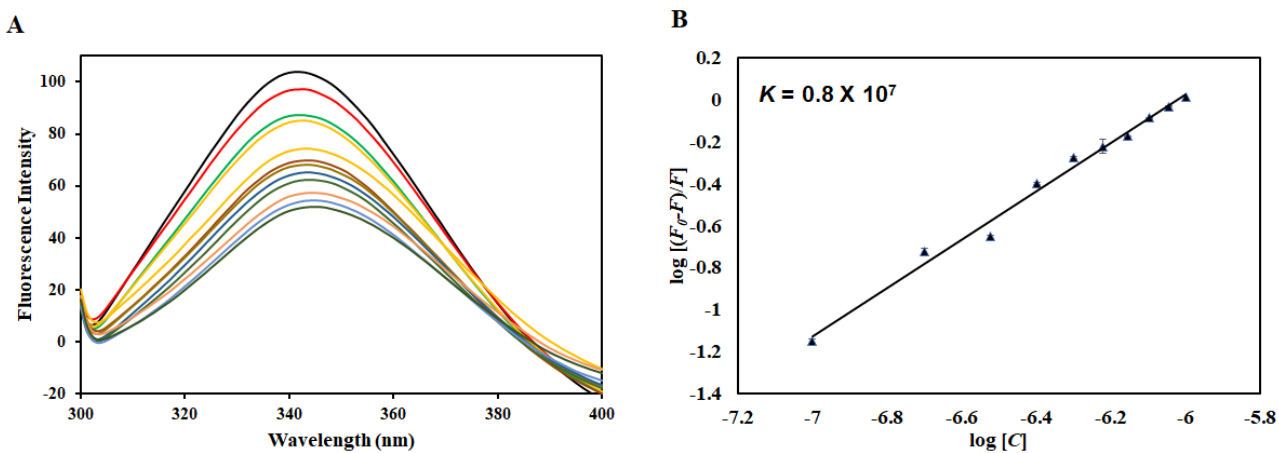
Figure 1. ( A ) Intrinsic fluorescence of MARK4 in the absence and presence of irisin (0–1 µ M). ( B ) Modified Stern–Volmer plot of MARK4–irisin interaction to find binding constant.